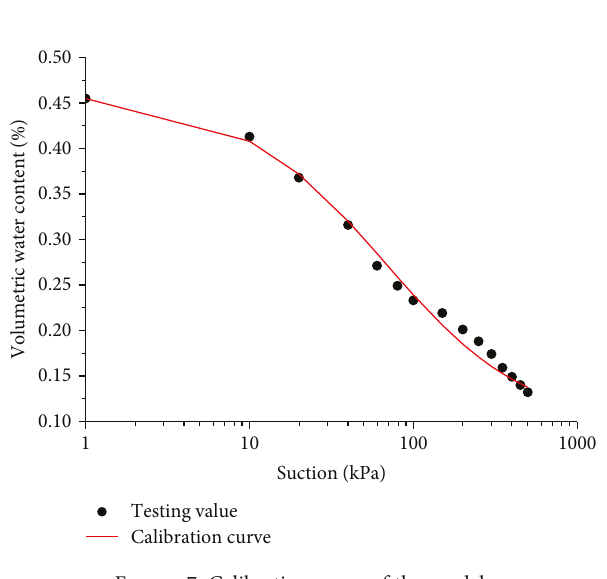
Figure 6: Preparation of remolded loess sample.